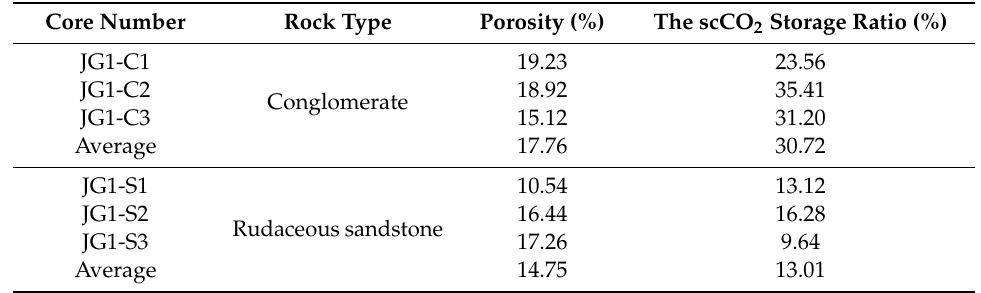
Table 2. The scCO 2 storage ratios of conglomerate and rudaceous sandstone cores at the Janggi